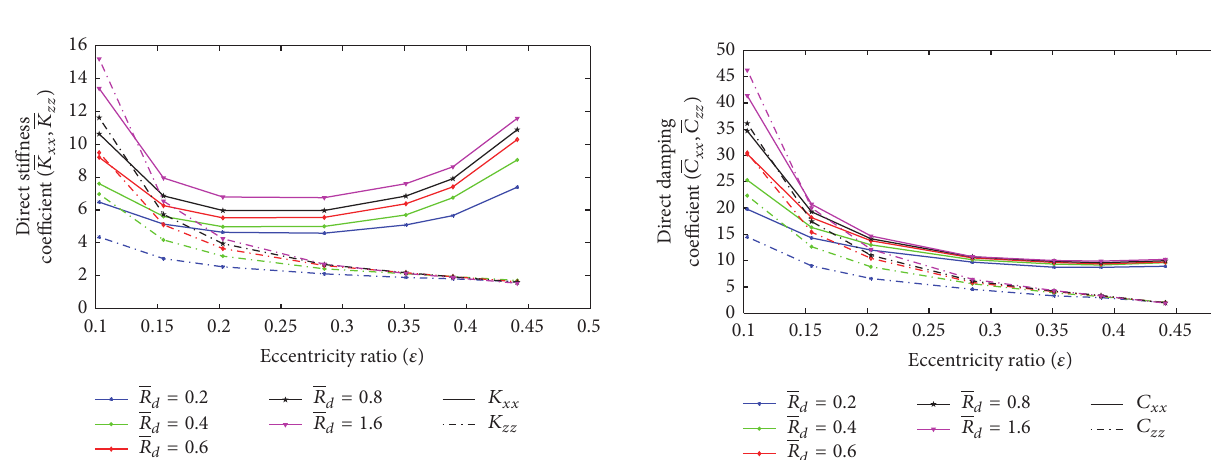
Figure 9: Effect of relief track depth ratio on cross-coupled stiffness coefficient.